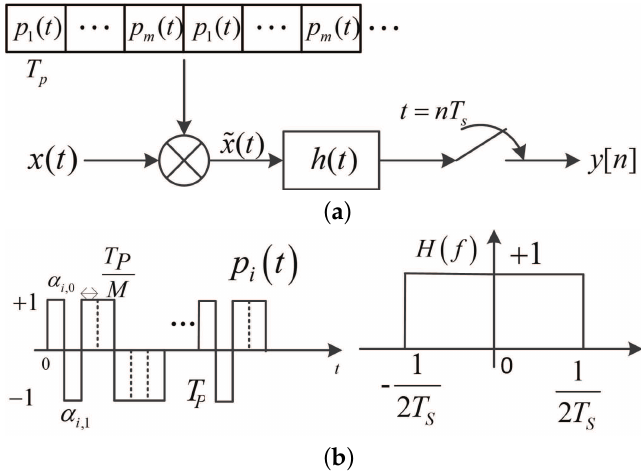
Figure 2. The Schematic Diagram of a single channel modulated wideband converter (SCMWC) sampling scheme ( a ). Periodic Waveform and low-pass filter (LPF) Frequency Response ( b